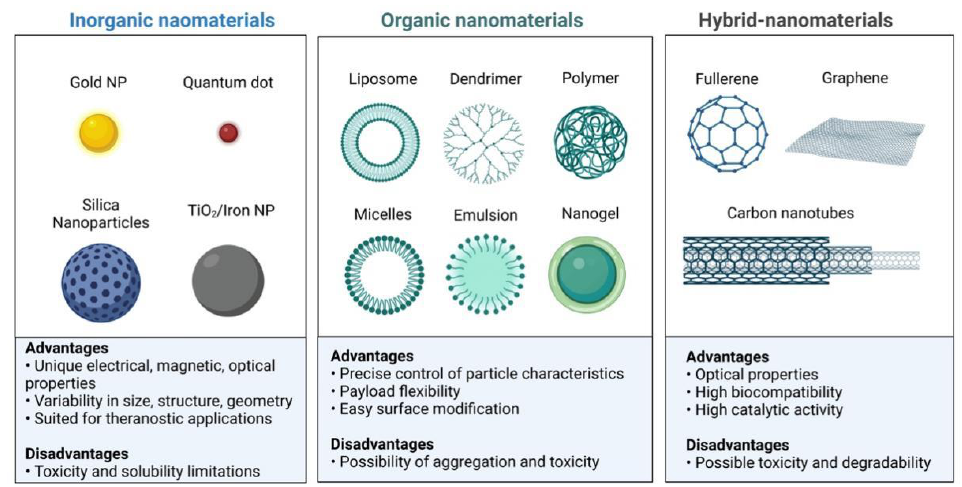
Figure 2. Nanoparticles have been demonstrated to possess great advantages including abundant surface modification, tunable structures, high loading capacity of biomolecules, and controllable release molecules.